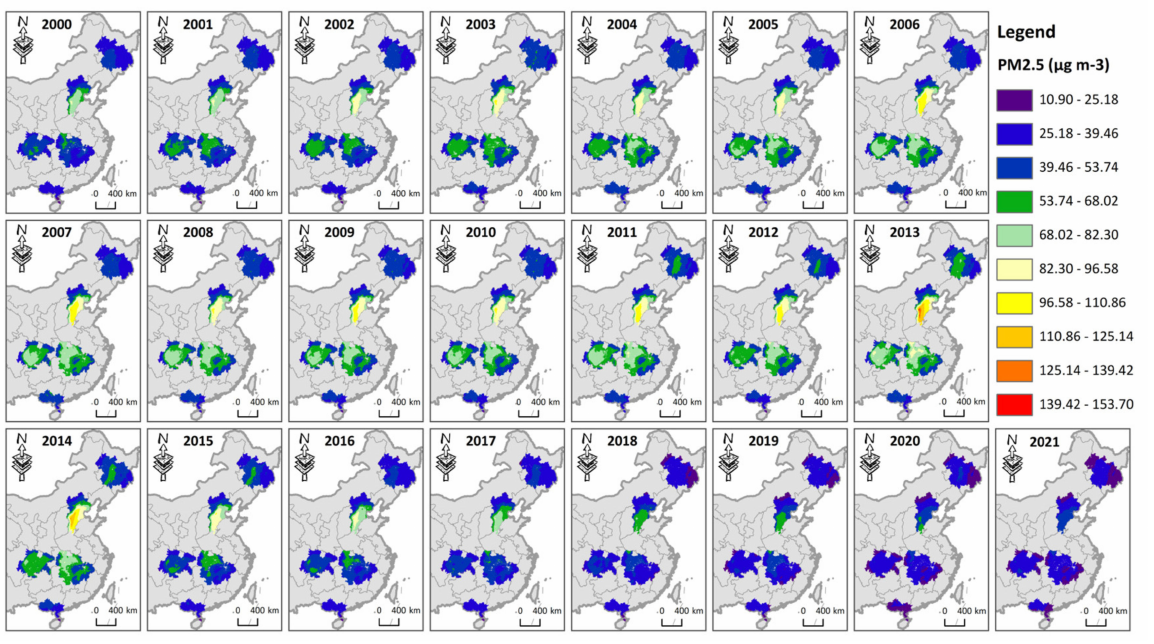
Figure 4. Spatial pattern of PM 2.5 concentrations in the five UAs during 2000–2021. PM 2.5 : Fine particulate matter ≤ 2.5 µ m in aerodynamic diameter (unit: µ g/m 3 ).